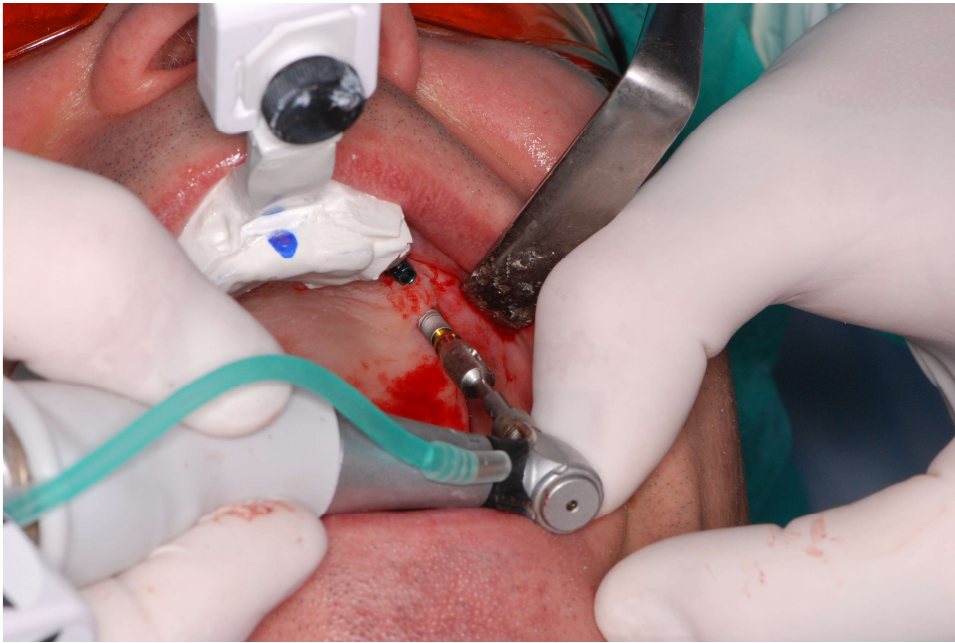
Figure 1. The dynamic navigation system in use—a surgeon performing a flapless implantation.